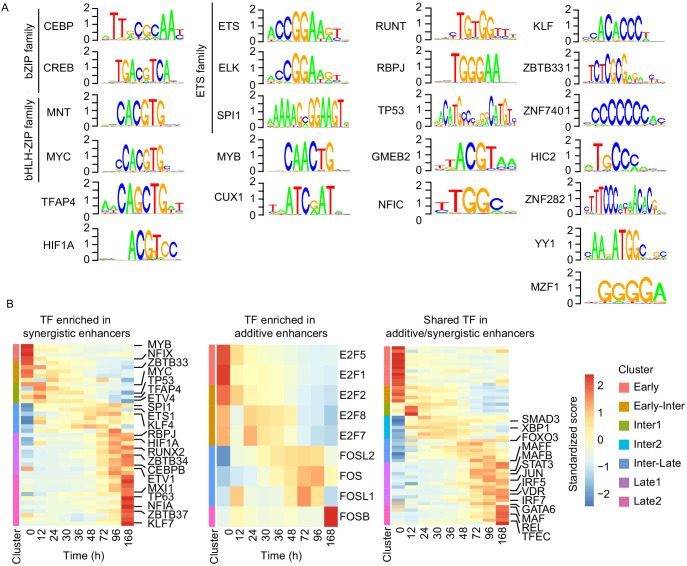
Cell type-specific transcription factors are enriched in synergistic enhancers.(A) Motifs of TFs enriched in synergistic enhancers from TF footprinting analysis (Materials and methods). (B) Expression of differentially expressed TFs (| log2(FC) |>1, FDR < 0.05, RNA-seq) enriched in synergistic (left panel), additive (middle panel), and both synergistic and additive (right panel) enhancers.